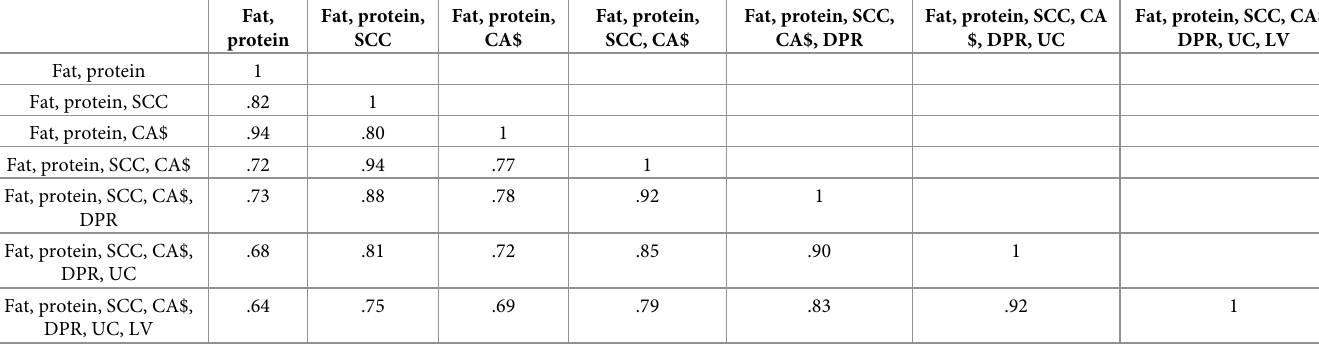
Table 5. Correlations for technical efficiency for bulls across models using various outputs. Fat, Fat, protein, Fat, protein, Fat, protein, Fat, protein, SCC, Fat, protein, SCC, CA Fat, protein, SCC, CA$, protein SCC CA$ SCC, CA$ CA$, DPR $, DPR, UC DPR, UC, LV Fat, protein 1 Fat, protein, SCC .82 1 Fat, protein, CA$ .94 .80 1 Fat, protein, SCC, CA$ .72 .94 .77 1 Fat, protein, SCC, CA$, .73 .88 .78 .92 1 DPR Fat, protein, SCC, CA$, .68 .81 .72 .85 .90 1 DPR, UC Fat, protein, SCC, CA$, .64 .75 .69 .79 .83 .92 1 DPR, UC, LV